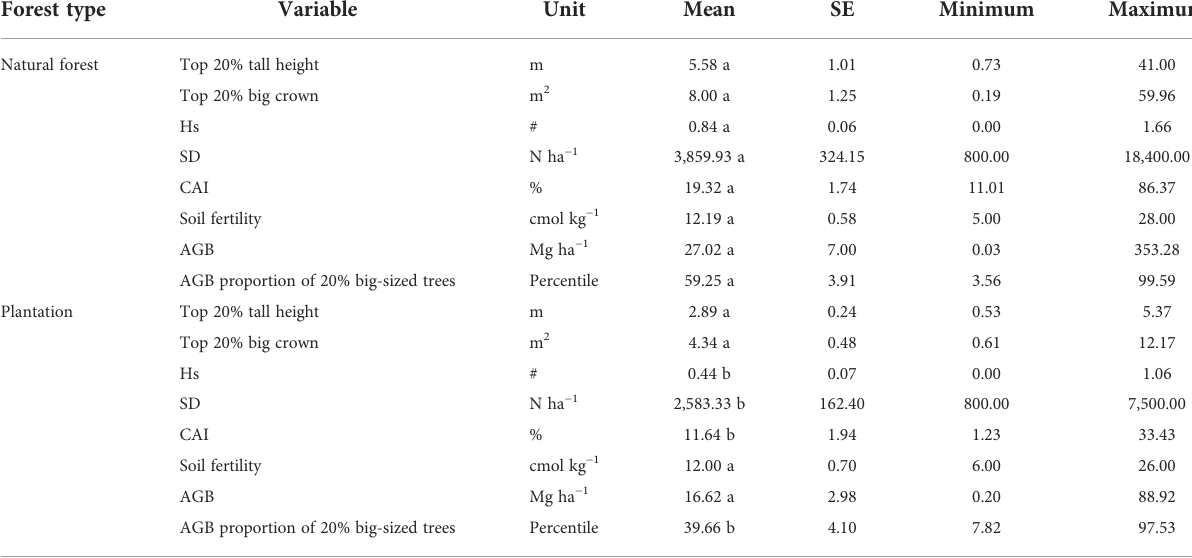
TABLE 1 Summary of the variables, from 73 natural forest plots and 30 plantation plots, was used in this